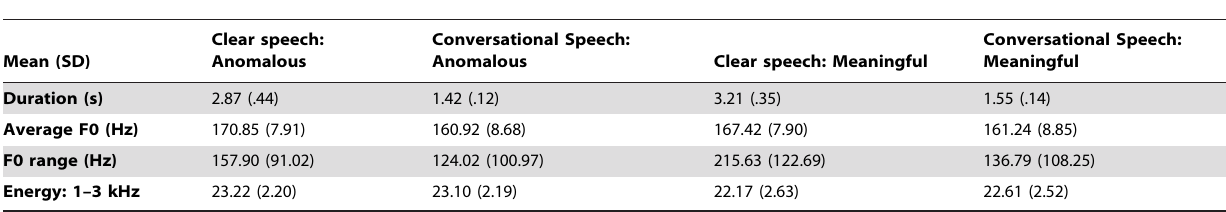
Table 1. Acoustic measures of sentence materials by speaking style and material type.